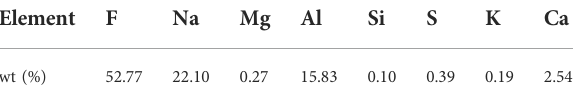
TABLE 1 Element components from XRF analysis.